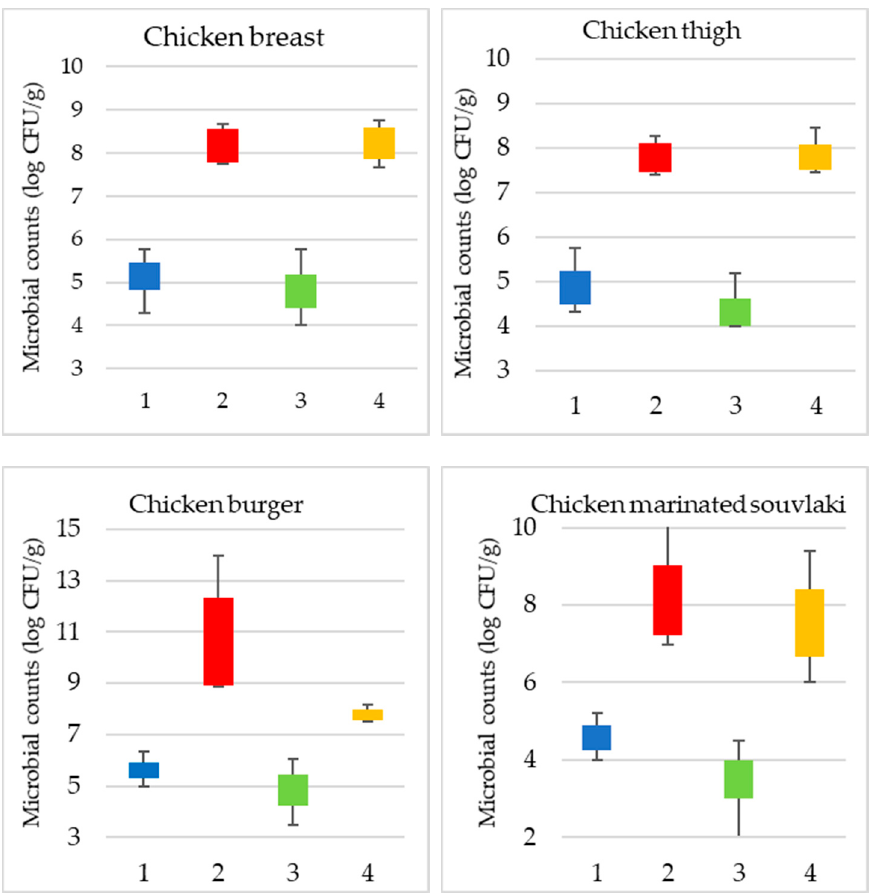
Figure 1. Boxplots for microbial counts (log CFU/g) of TVC (1: blue,2: red) and Pseudomonas spp. (3: green,4: orange) in fresh (1: blue,3: green) and spoiled (2: red,4: orange) samples of each product.